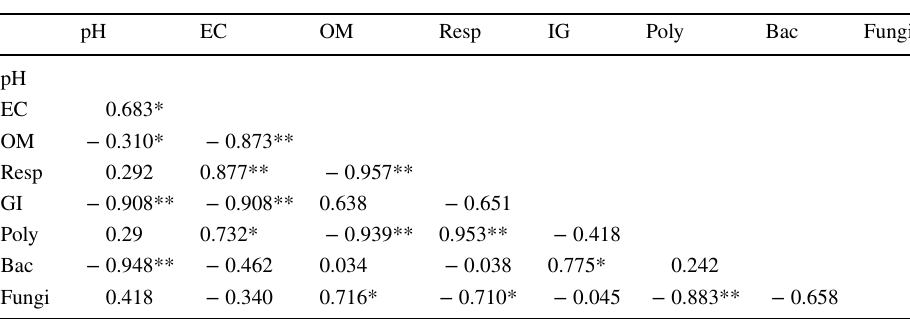
pH, EC (Electrical Conductivity) OM (Organic Matter), Resp (Respiration), GI (Germination index), Poly (Polyphenol compounds), Bac (Bacterial mesophilic), Fungi